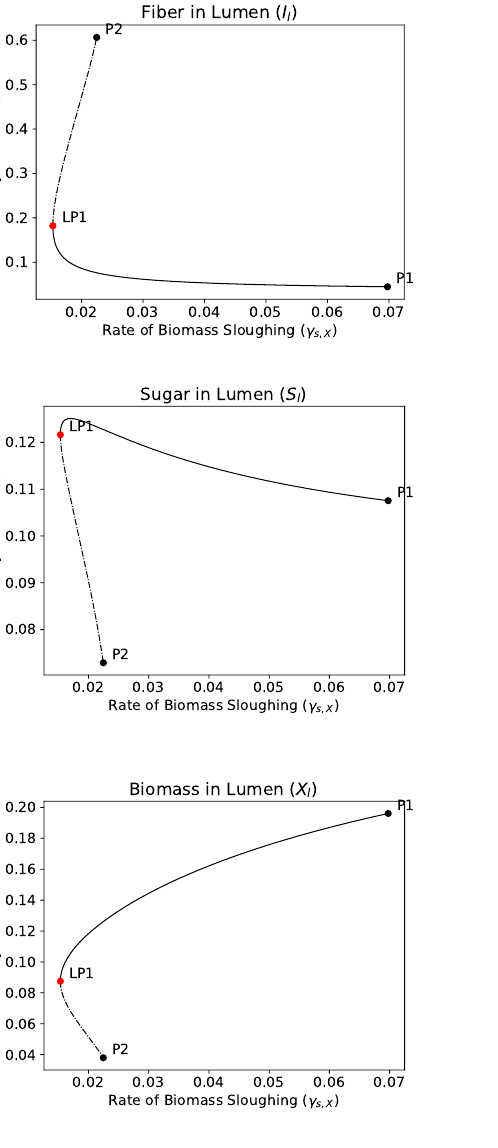
Figure 7. Steady state values of dual compartment model (Equations (4)–(9)) plotted as a function of the rate of sloughing of biomass from the mucus to lumen ( γ s , X ). The solid and dashed lines indicate stable and unstable steady states, respectively. P1 and P2 refer to the start and end points of the continuation. LP1 is the limit